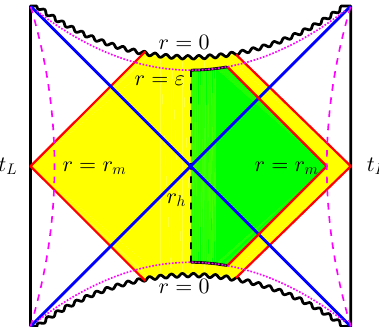
Figure 5 . The penrose diagram and the regularized approach of the WDW patch for t R = t L = 0 in the Schwarzschild AdS black holes. The null boundaries of the WDW patch come from the (cid:12)nite cut-o(cid:11) boundary and there is a null-null joint at the cut-o(cid:11) r = r m . In addition, in order to regularize the singularity, we need to use an additional cut-o(cid:11) at r = " ! 0, so there are also some new joints and space-like